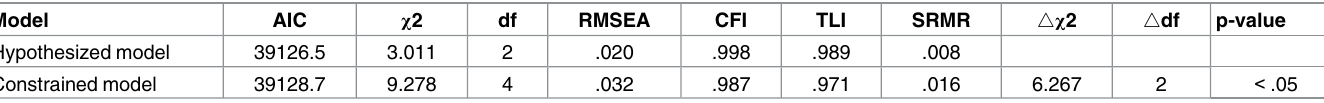
Table 4. Fit indices for crossover